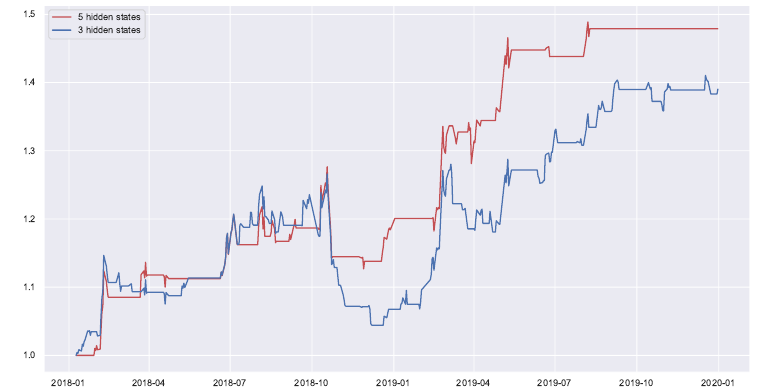
Figure 9. Hidden Markov situation estimation trading strategy yield index curve under different hidden state